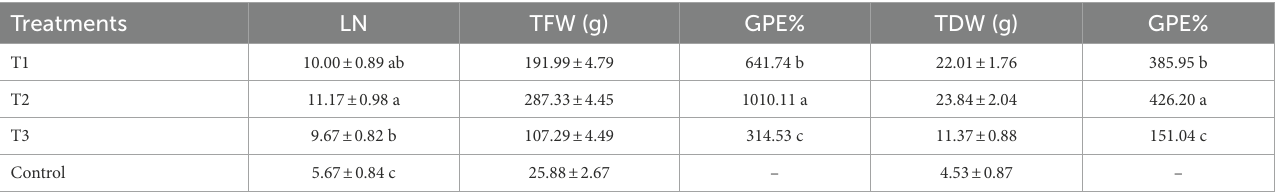
TABLE 2 Effects of MF-HZ23 on growth promotion of